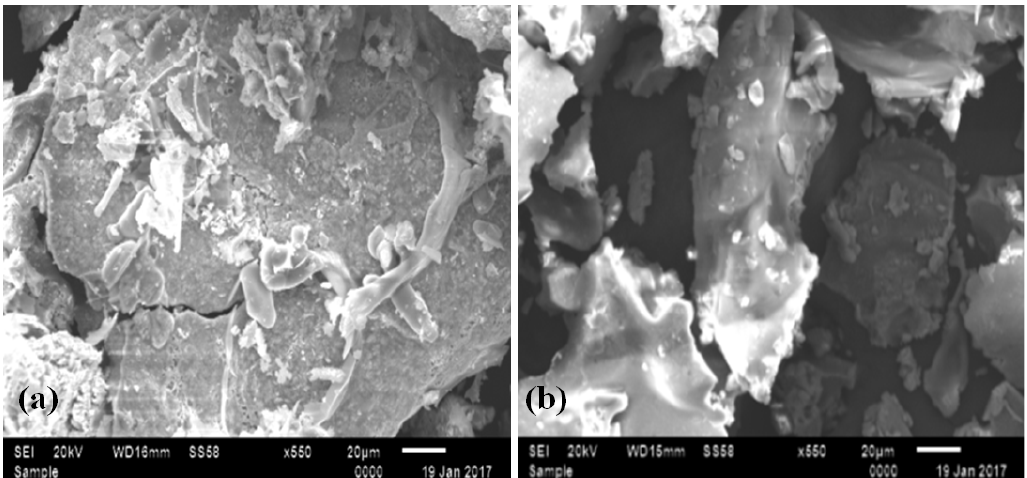
Fig.3. SEM images of AgNPs prepared with L.glutinosa ( a). Leaf and (b). Stem extract